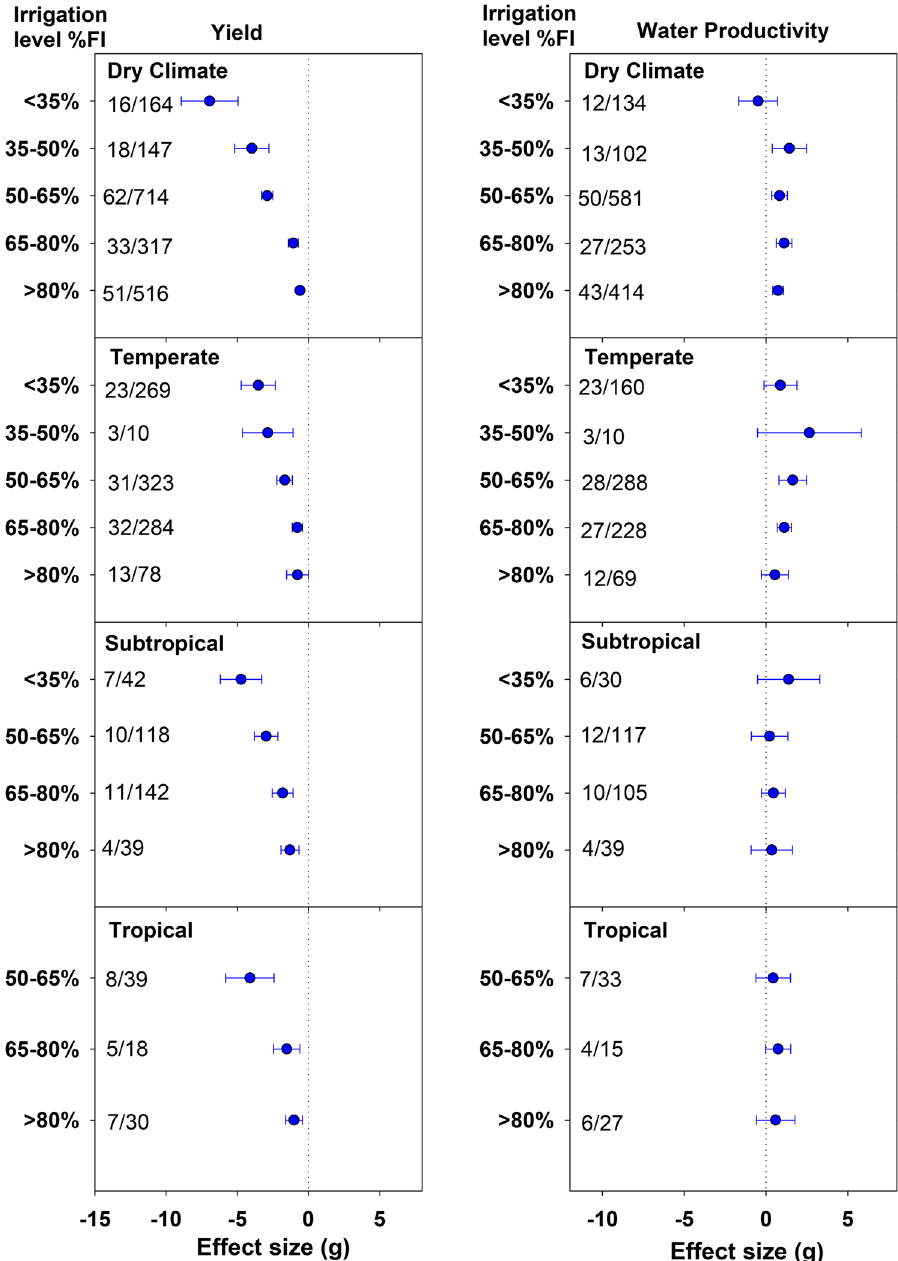
Figure 4. Effect of deficit irrigation levels on yield and water productivity (WP) under different climatic conditions. The dotted line (effect size = 0) represents full irrigation. Effect size > 0 indicates increase and effect size < 0 indicates reduction in yield and WP for deficit irrigation level relative to full irrigation (FI). Non- overlapping confidence intervals (horizontal bars) indicate significant differences. Numbers on right side of Y-axis represent number of